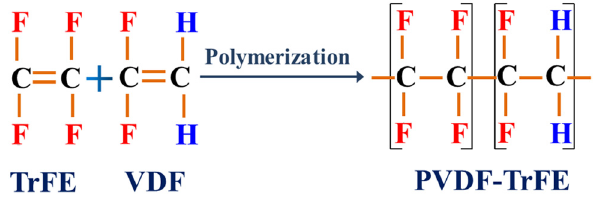
Figure 7: Polymerization of PVDF -